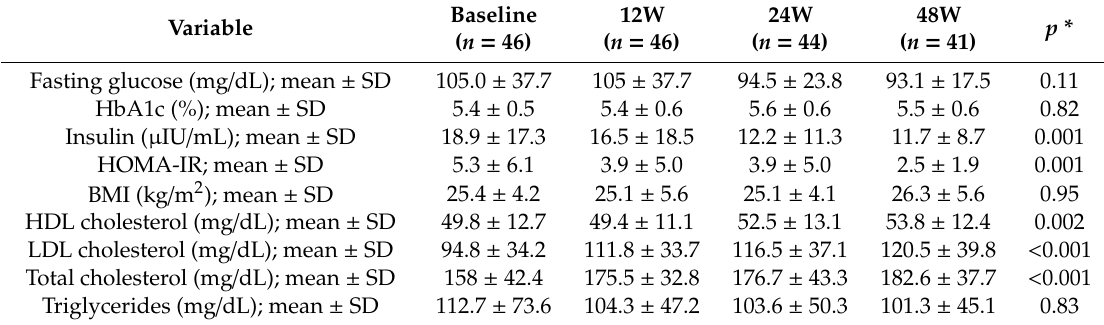
Table 3. Changes in metabolic parameters during and after DAA